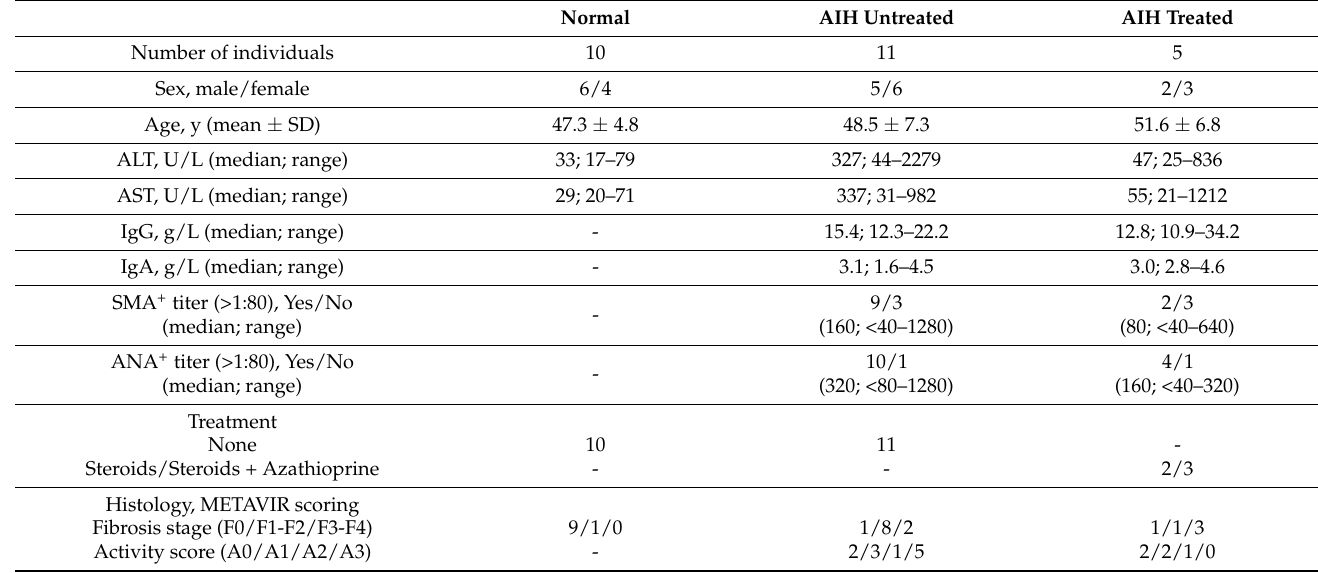
Table 1. Clinical, biological and histological features of